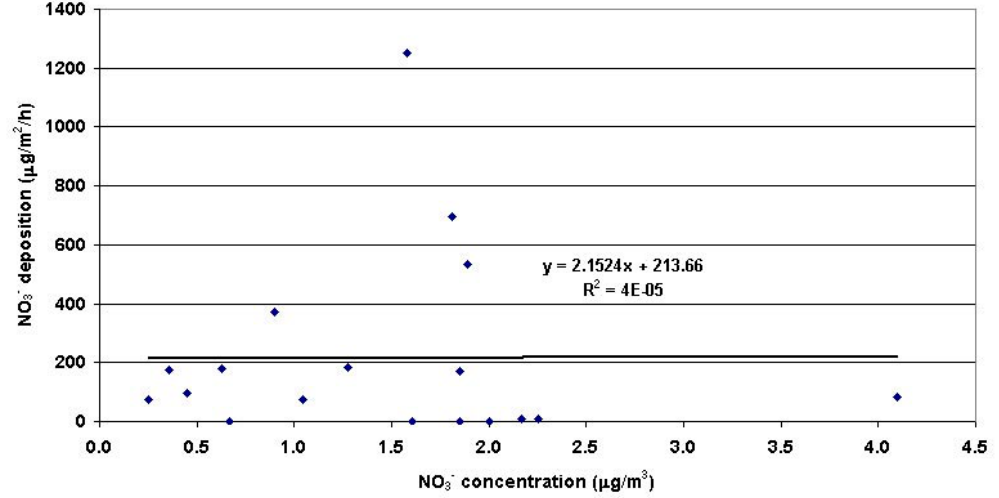
FIGURE 2. Ambient concentrations of particulate NO 3- and rates of NO 3- deposition to nylon filters were not correlated.